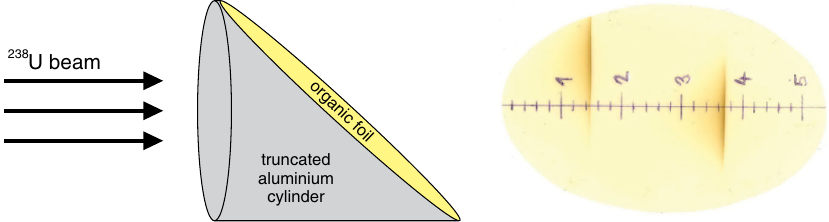
FIG. 4. Principal scheme of the complementary experiment using the truncated aluminum cylinder with an organic foil (left) and the corresponding darkened regions on the foil created with 238 U ions (right) with the initial energy 500 MeV = u (shorter range) and 950 MeV = u (longer